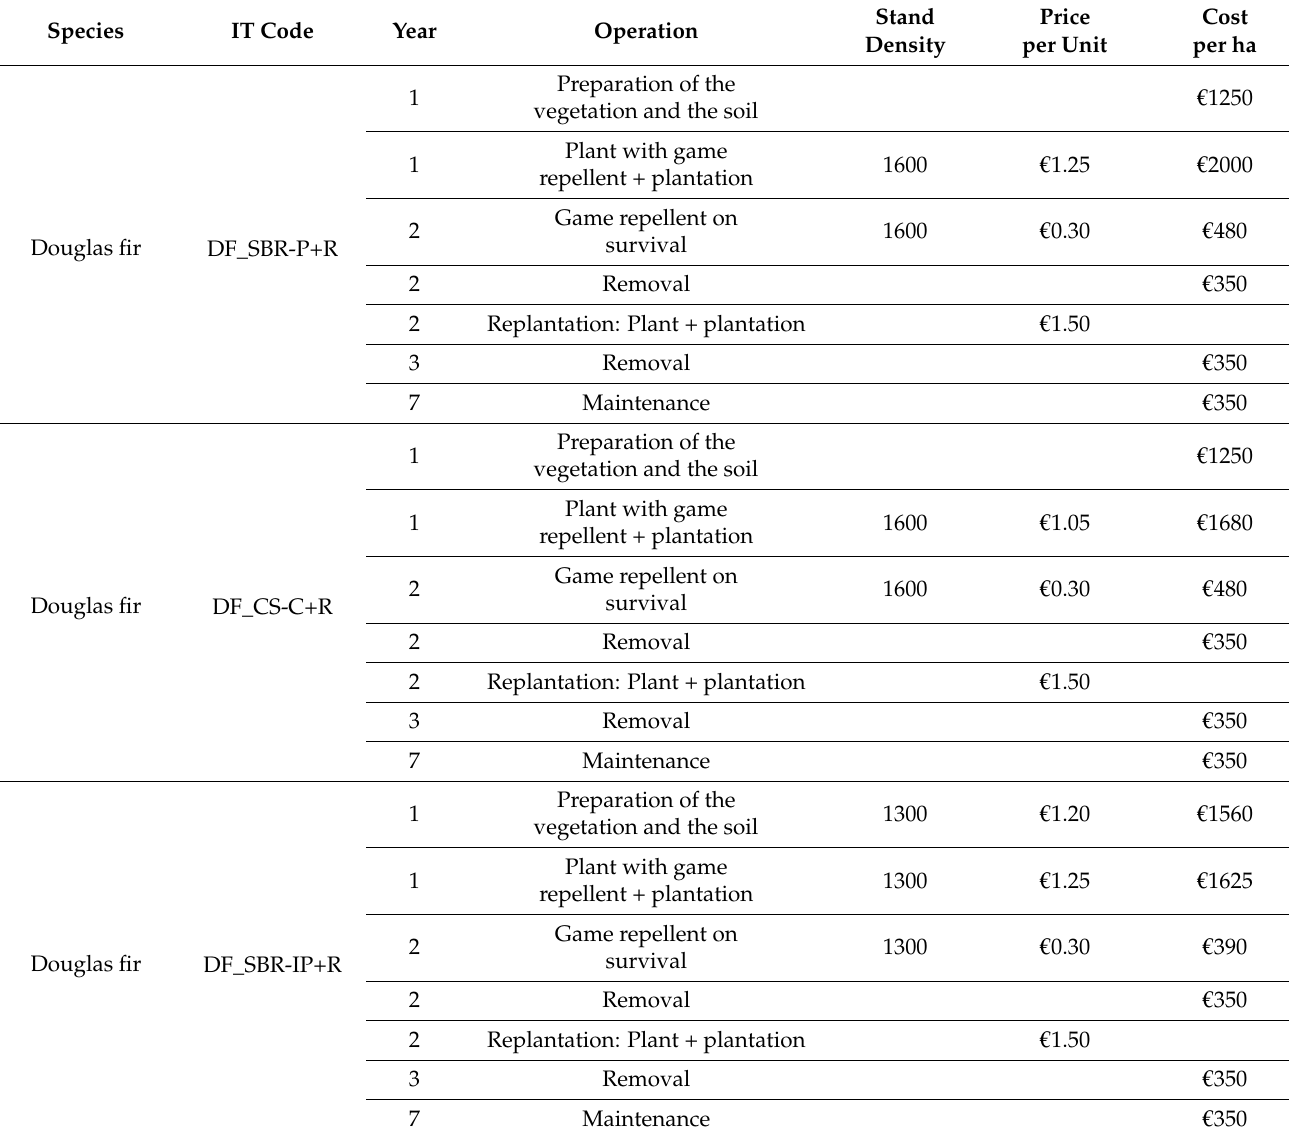
Table A1. Itinerary of plantations with the detailed operations associated with their year of realization and their costs in EUR for Douglas fir and sessile oak. The itinerary code corresponds to the species (DF for Douglas fir ( Pseudotsuga menziessi Mirb.), SO for sessile oak ( Quercus petraea Liebl.)), followed by the type of plants (CS for container seedlings, SBR for seedlings supplied with bare roots), the plantation type (C for plantation with a cane, P with a pickaxe, IP in individual pits), and game protection (F for fencing, IGP for individual protection, R for game